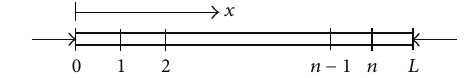
Figure 1: One-dimensional heat conduction model with unknown boundary